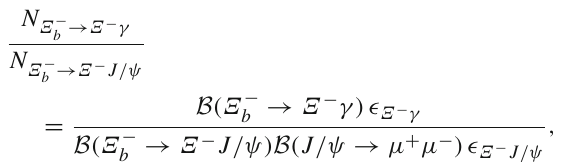
Fig. 8 New Physics constraints on Re ( C (cid:7) 60]. A (cid:18)Γ φγ in blue, S K ∗ γ in violet, α γ (assuming a value of α γ = 1 . 0 ± 0 . 15) in orange, the inclusive radiative branching ratio in yellow, the angular study of B → K ∗ e + e − in purple and the combination of all this measurement except for the α γ one in green. Besides, the SM value is marked with a star